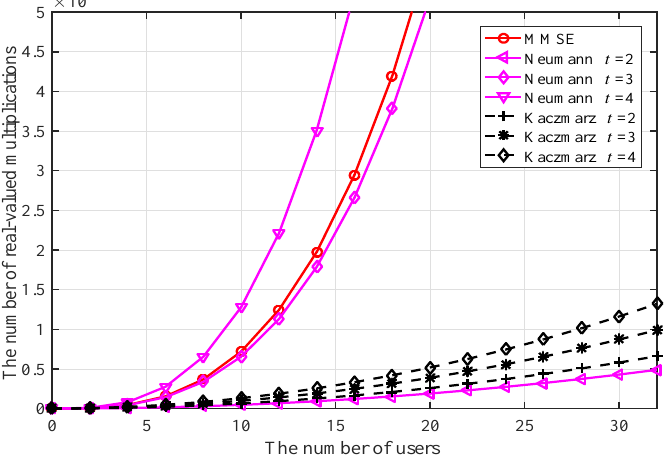
Figure 1. Algorithms complexity